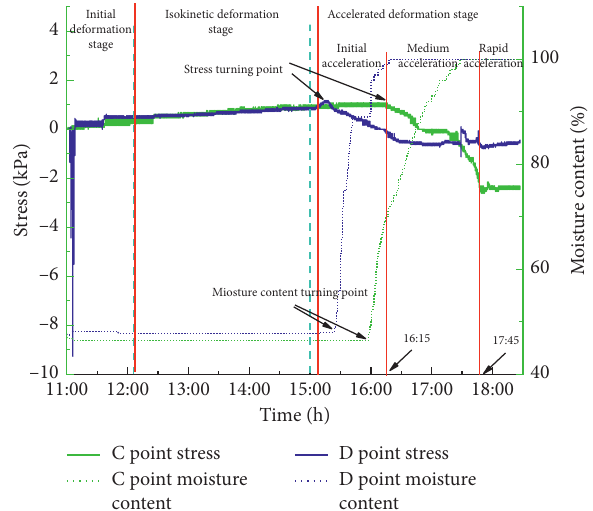
Figure 15: Stress-moisture content time history curve at C and D measuring points of the vertical section of slope foot.